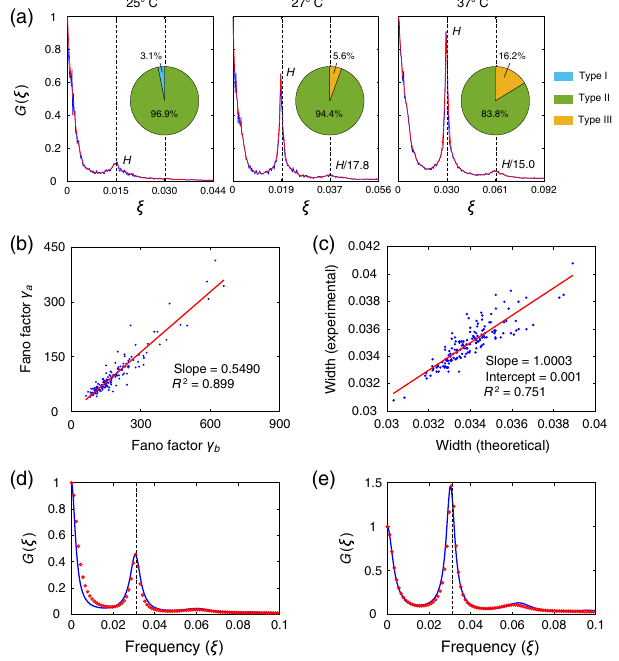
FIG. 4. Analysis of single-cell time course data of fluorescence intensities in E. coli published in Ref. [2]. (a) Average power spectra over all cell lineages at three different temperatures (blue curves) and their smoothed approximations (red curves) using the Gaussian filter. The average spectra are estimated by means of the Wiener-Khinchin theorem, where 65, 54, and 160 cell lineages are averaged over, respectively, for the three growth conditions. The power spectrum for each cell lineage is also estimated by fitting the time course data to an AR model. The pie charts display the percentages of various types of power spectra for all cell lineages. (b) Comparison between the Fano factor γ fluorescence intensities just before division and the Fano factor γ of those just after division for all lineages at 37 °C. (c) Comparison between the widths of the experimental power spectra obtained using the AR model technique and the theoretical power spectra determined using the estimated parameters for all lineages at 37 °C. (d),(e) Comparison between the experimental (blue curve) and theoretical (red circles) power spectra for two typical lineages at 37